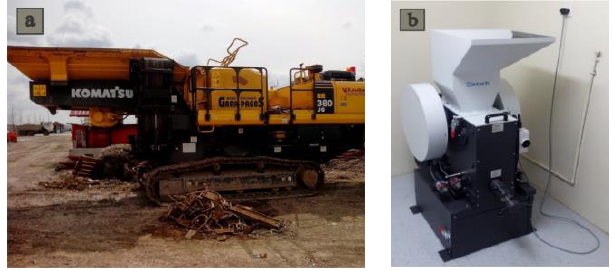
Figure 1. The aggregate crushing process used to transform concrete waste into recycled concrete aggregate (RCA): ( a ) mobile jaw crusher; ( b ) laboratory jaw crusher.